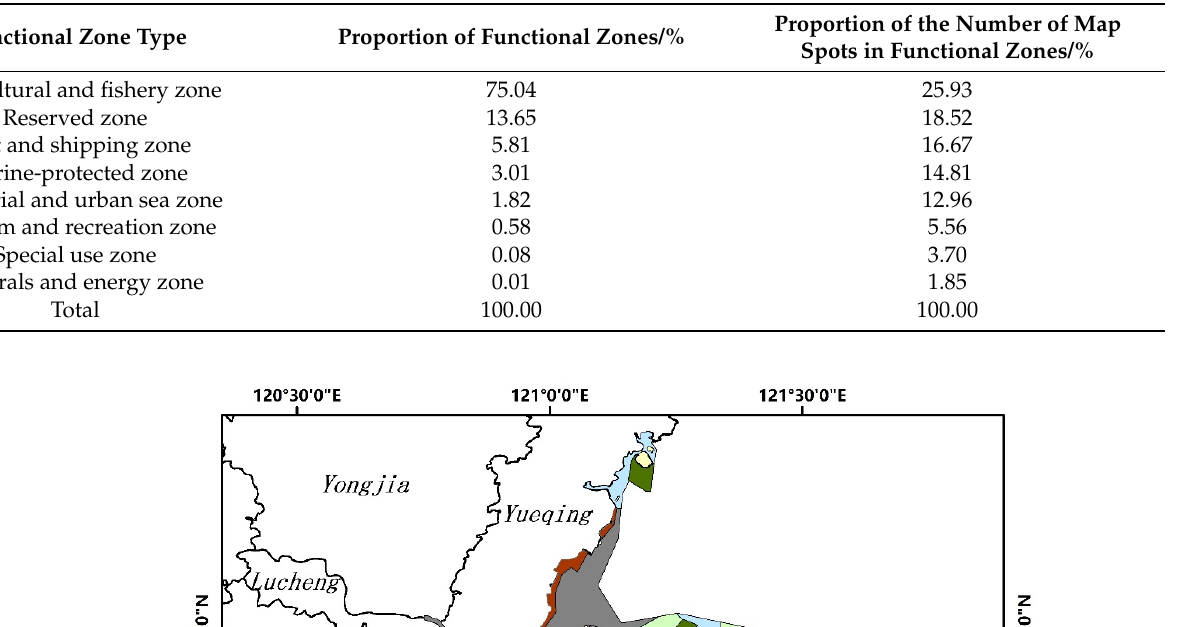
Table 3. The structure of functional zones in Wenzhou Marine Functional Zoning (2013–2020).